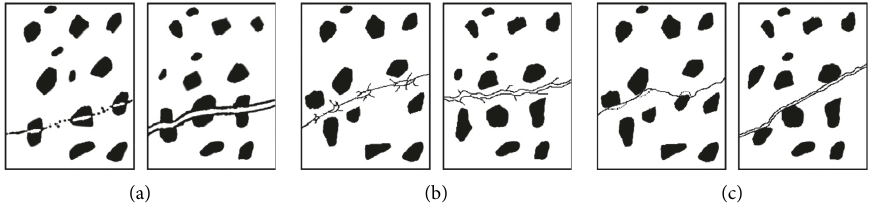
Figure 12: Different failure modes of particle reinforced composites.